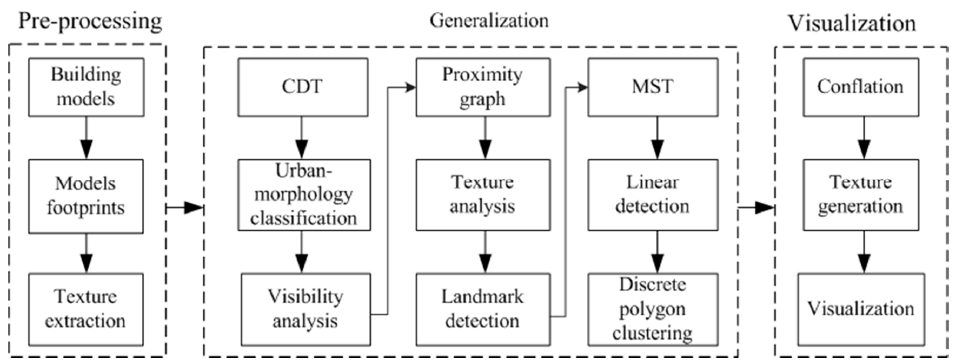
Figure 1. Algorithm framework.